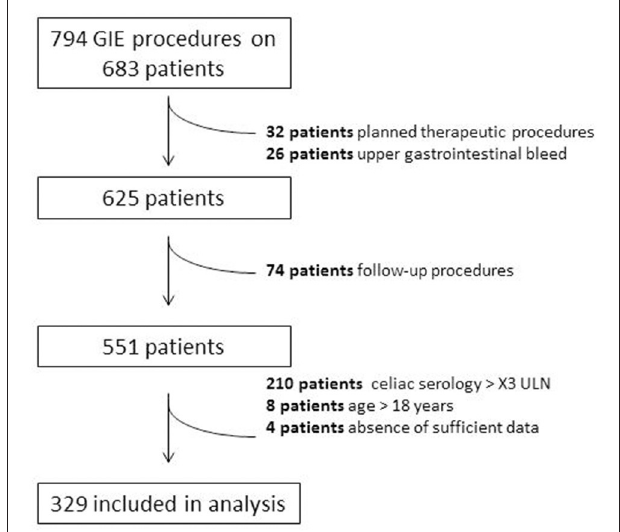
FIGURE 1 | Selection of patients included in